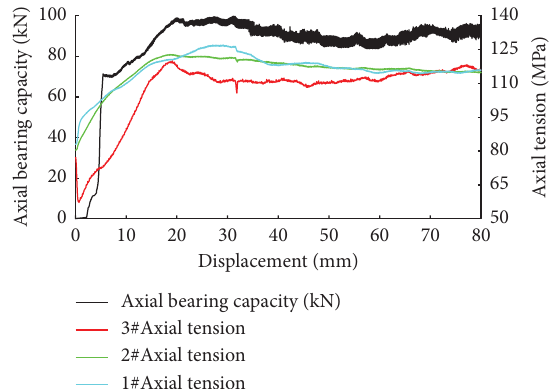
Figure 14: Te change in the curve of the internal force of the bolt when adding a rubber